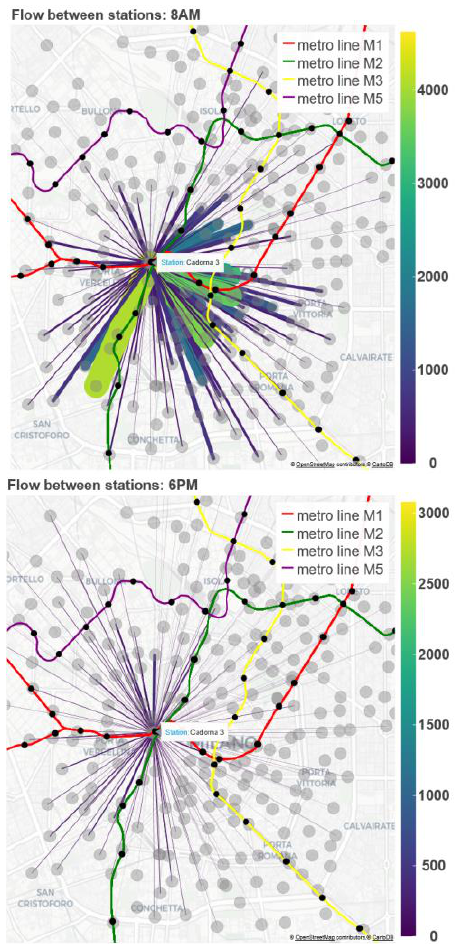
Figure 10. Mobility flows from “Cadorna 3” station, considering regular users only (trips count). 08:00 (top). 18:00